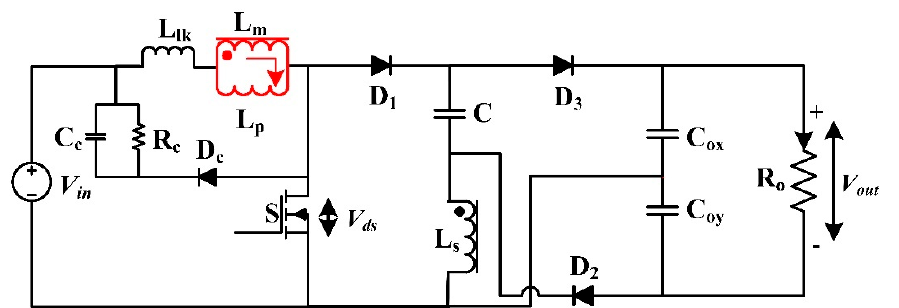
Figure 5. Third operating mode of the converter under DCM operation.